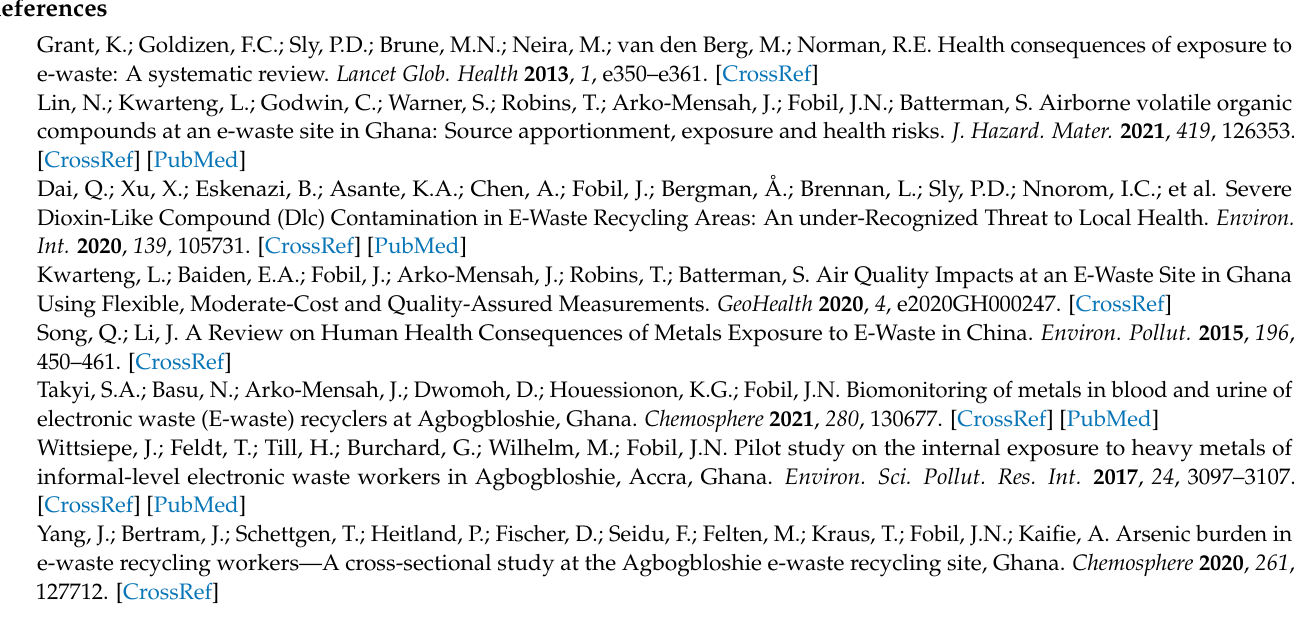
Table S5: List of excluded studies at full-text screening stage with brief reasons, Table S6: JBI Critical Appraisal Checklist for Analytical Cross Sectional Studies, Table S7: JBI Critical Appraisal Checklist for Cohort Studies. References [62–70] are cited in the supplementary